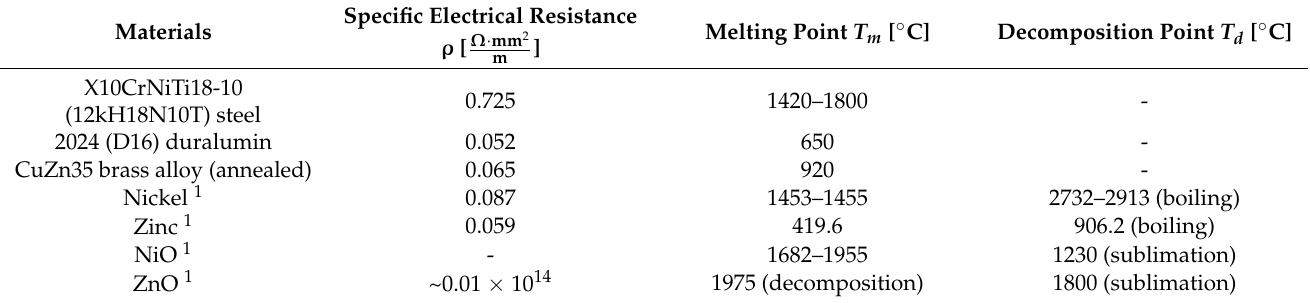
Table 5. Electrical and thermal properties of some materials at +20 ◦